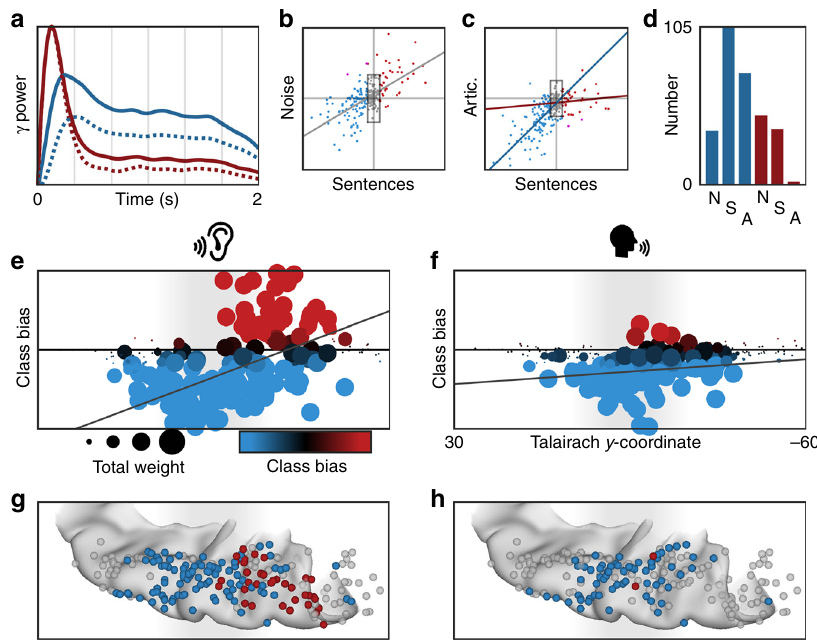
Fig. 8 Planum temporale responses are uniquely suppressed for self-generated speech. Supratemporal responses ( n = 247 electrodes) classi fi ed with 2- basis non-negative matrix factorization. a High-gamma power identi fi es a sustained (blue) and transient (red) response: normalized basis functions (dotted line) and the normalized group-average response for the top 10% of electrodes in each class (solid line). b The class bias determined by factorizations of electrode responses to noise and sentence listening — homogeneous and structure acoustic inputs — were signi fi cantly correlated. c The factorization from sentence listening was applied to the electrode responses at articulation. Sustained class bias was signi fi cantly correlated for listening and speaking, but the transient class biases were uncorrelated. d Class biases greater than a value of 10 generated discrete classi fi cations for speech listening (S; sustained, n = 105; transient, n = 37) and articulation (A; sustained, n = 74; transient, n = 2). e , f Spatial distribution of activation (sum of class weights; point size) and bias (difference in class weights; point color) reveals anteroposterior gradient of functional response during speech listening (left) but not articulation (right). g , h Electrodes shown on a standard supratemporal atlas reveal that the transient response is localized to PT and is uniquely suppressed during